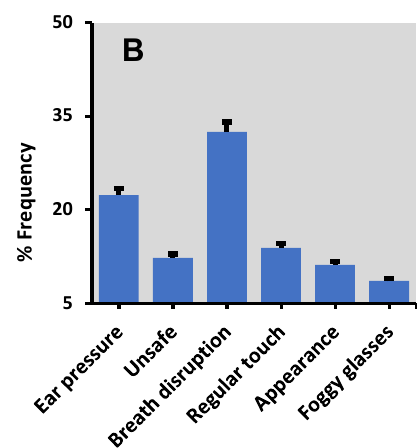
Figure 1. Nose mask usage as indicated by the respondents. ( A ) Comfortability and non-comfortability of nose masks. ( B ) Factors for the discomfort of nose mask usage. Error bars indicate the number of participants comfortable with nose masks ( A ) and the percentage of discomfort ( B ).